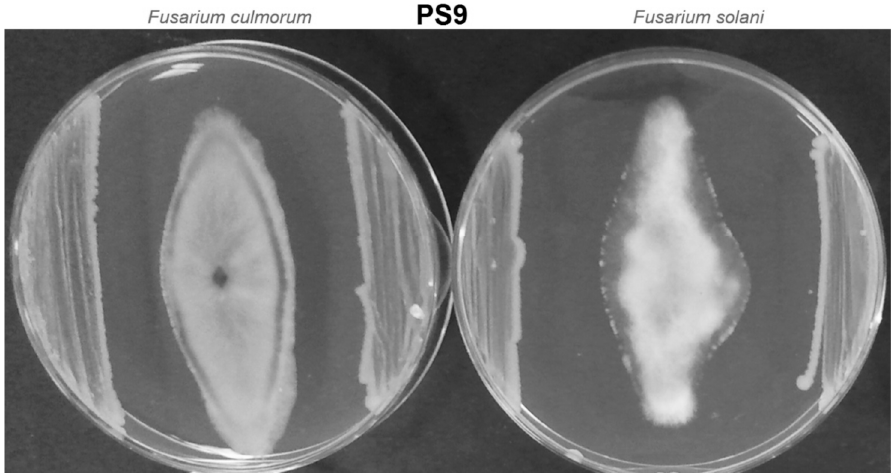
Figure 2. Growth inhibition of Fusarium spp. strains caused by the Ps-9 strain using the dual culture method.